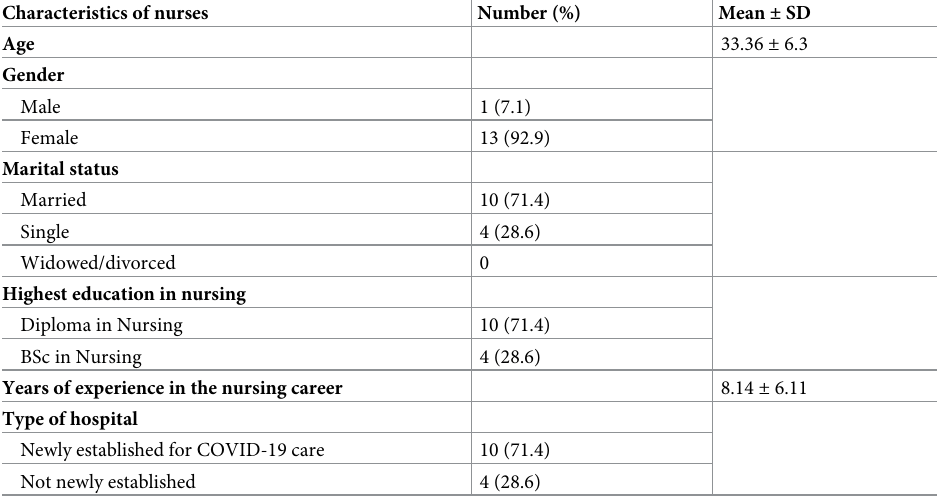
Table 2. Demographic information of participants (n =